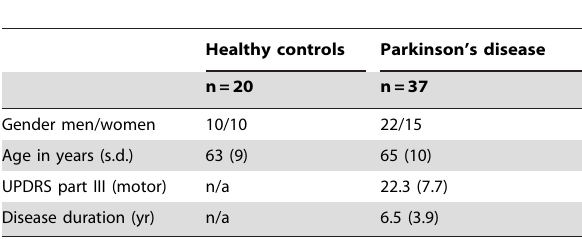
Table 1. Demographic data on patients and healthy controls.